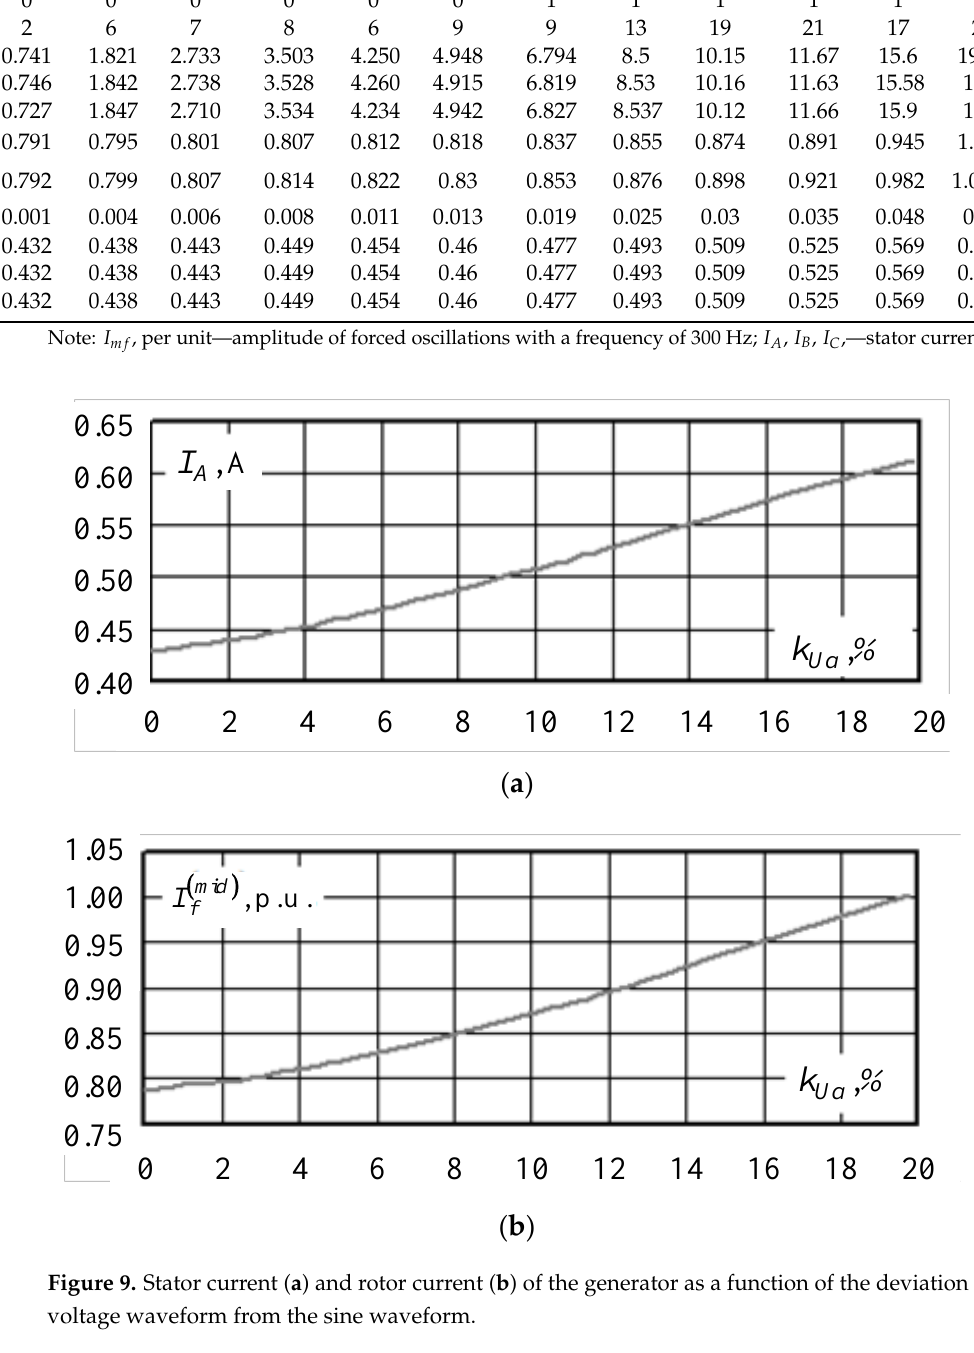
Table 5. Experimental data for the MATLAB model of the turbogenerator serving a non-sine wave- form load.